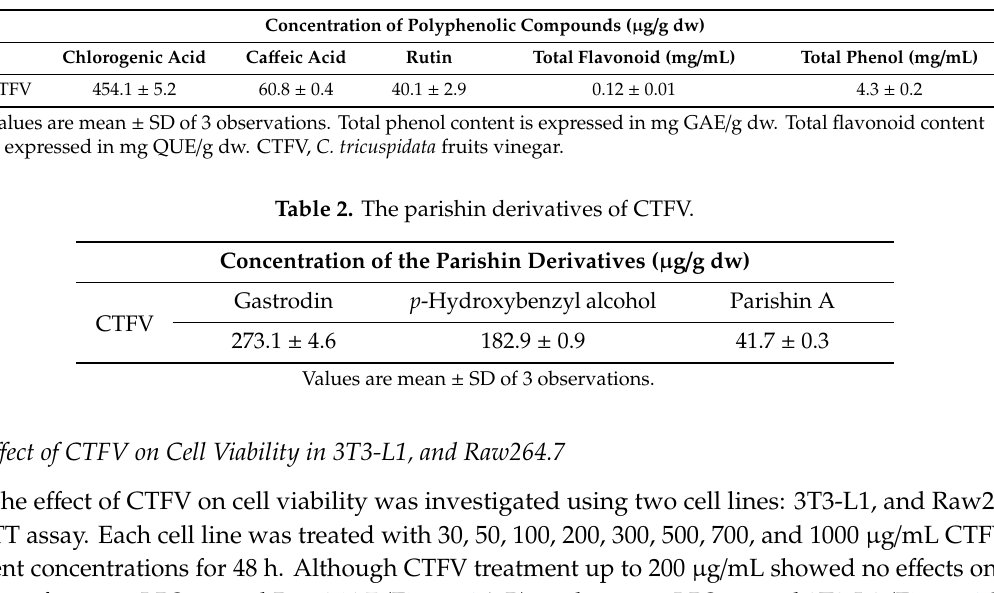
Figure 1. HPLC analysis of polyphenolic ingredients ( B ) and parishin derivatives ( D ) from CTFV. Mixture of authentic standards for polyphenolics ( A ) and parishin derivatives ( C ). X -axis is retention time in minutes and Y -axis is absorbance unit (AU). 1, gallic acid; 2, protocatechuic acid; 3, chlorogenic acid; 4, p -hydroxybenzoic acid; 5, caffeic acid; 6, isovanillic acid; 7, rutin; 8, p -coumaric acid; 9, ferulic acid; 10, taxifolin; 11, trans-coumaric acid; 12, rosmarinic acid; 13, quercetin; 14, trans-cinnamic acid (A, left panel). 1, gastrodin; 2, p -hydroxybenzyl alcohol; 3, parishin E; 4, parishin B; 5, parishin C; 6, parishin A (C, right panel). Table 1. The polyphenolic ingredients of CTFV.